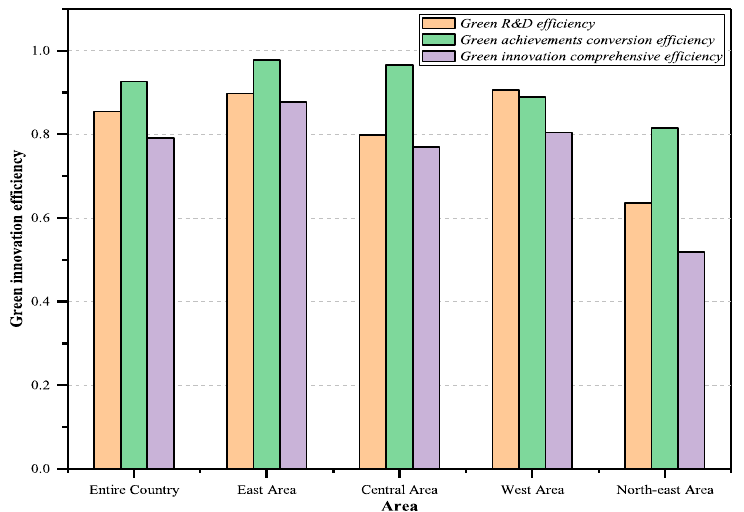
Figure 2. Green technology innovation efficiency of the country and sub-regions.